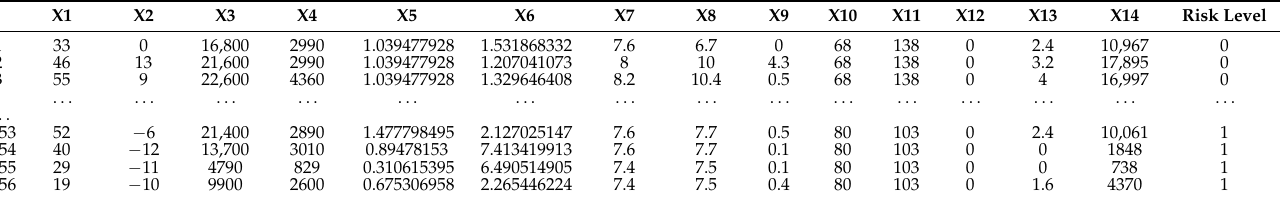
Table 1. Rockburst monitoring raw